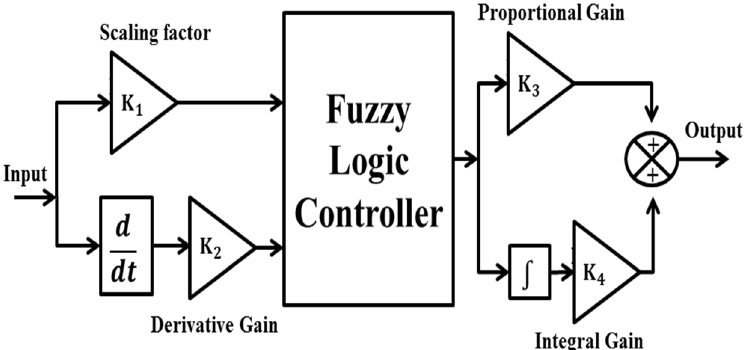
Figure 3. Fuzzy assisted PID controller.